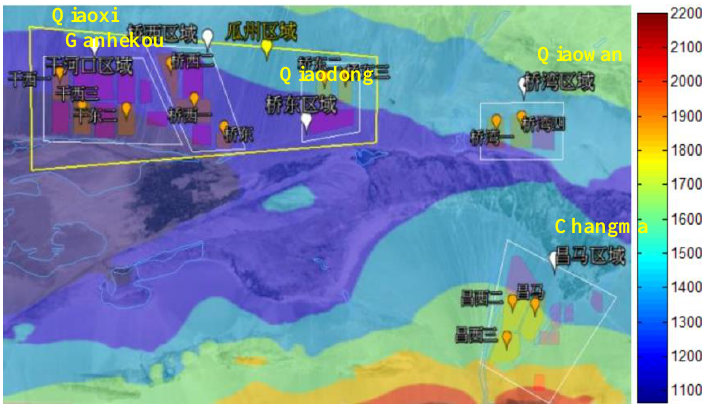
Figure 6. Gansu wind areas and geographical altitudes of the Jiuquan wind power base.